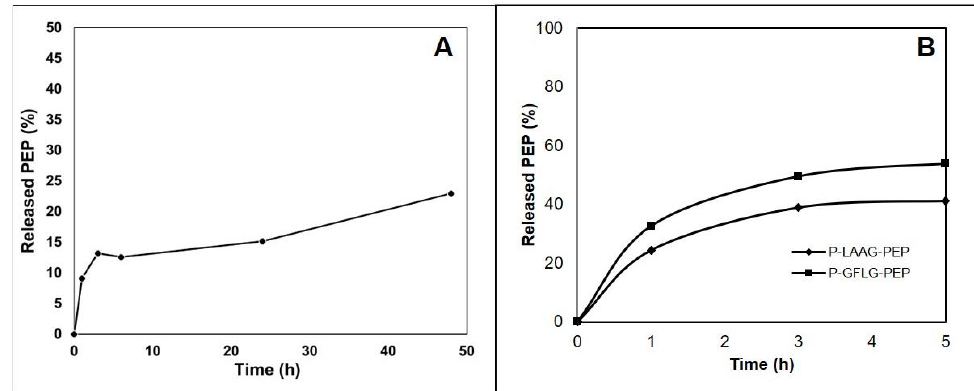
Figure 4. ( A )Hydrolytic release of levulinyl-PEP from the polymer conjugate P-Hyd-PEP at pH Figure 4. ( A ) Hydrolytic release of levulinyl-PEP from the polymer conjugate P-Hyd-PEP at pH 7.4. ( B ) Cathepsin B-catalyzed release of PEP from the polymer